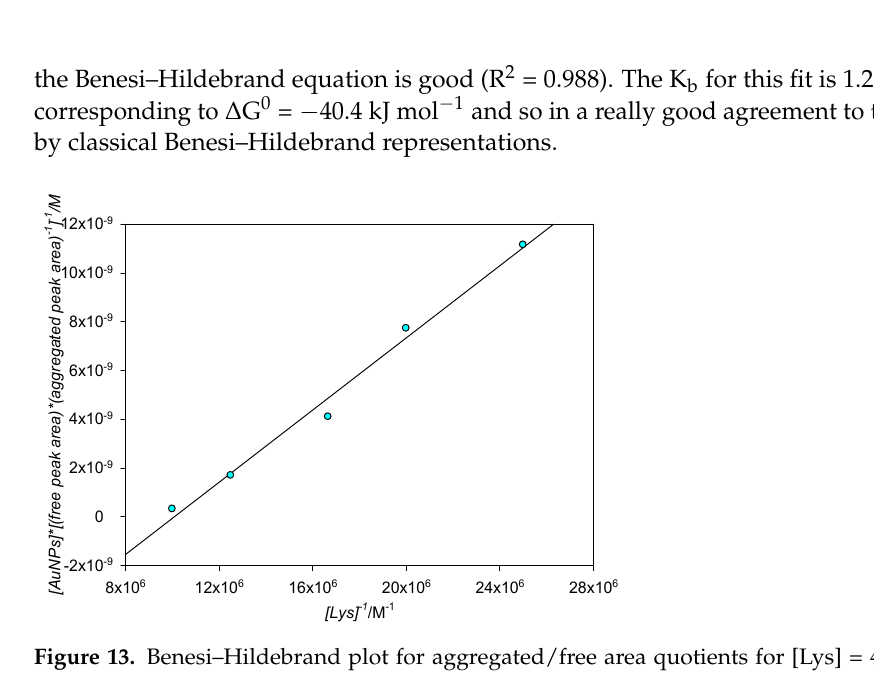
lysozyme complex, Figure S1: ζ -Potential of 10 nm AuNPs, Figure S2: (A) Changes of the maximum of the SPB ( λ max ). (B) Changes of the ratio A 569 /A 518 at each protein concentration of Table 1. [AuNPs] = 8.22 × 10 − 10 M, Figure S3: (A) SPB of 5, 10 and 20 nm AuNPs at the same nanopar- ticle concentration. [AuNPs] = 8.22 × 10 − 10 M. (B) SPB of 5, 10 and 20 nm AuNPs at the same gold concentration. [Au] = 50 µ , Figure S4: Stability study of 20 nm AuNPs in the presence of [Lys] = 10 − 4 M. [AuNPs] = 8.22 × 10 − 10 M, Figure S5: (A) Stability study of 5 nm AuNPs in the presence of [Lys] = 4 × 10 − 4 M. [AuNPs] = 4 × 8.22 × 10 − 10 M; (B) Stability study of 10 nm AuNPs in the presence of [Lys] = 3 × 10 − 4 M. [AuNPs] = 8.22 × 10 − 10 M. (C) Stability study of 20 nm AuNPs